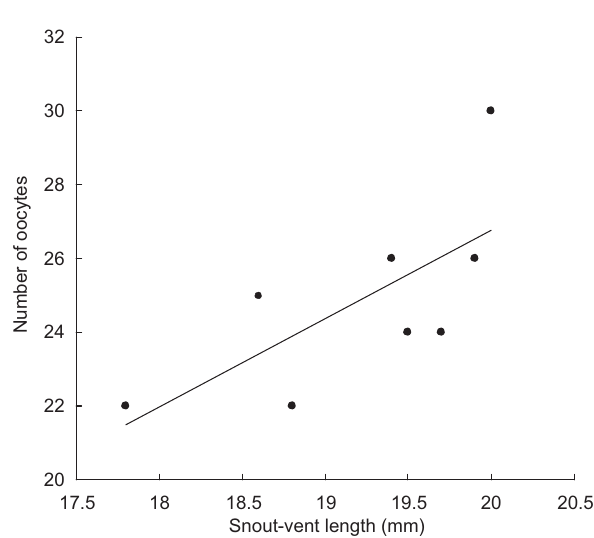
Concórdia.Figure 4. Relationship between snout-vent length (mm) and num- ber of oocytes of ovigerous females (in log) of I. parva in Santuário Ecológico da Serra da